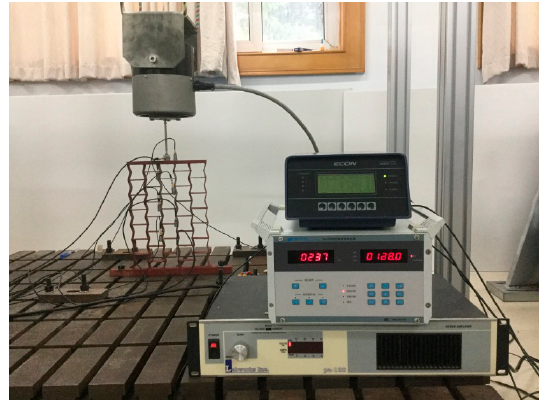
Figure 12. Testing samples with the cell angle θ = − 45 ◦ : ( a ) geometric dimensions; ( b ) photo.